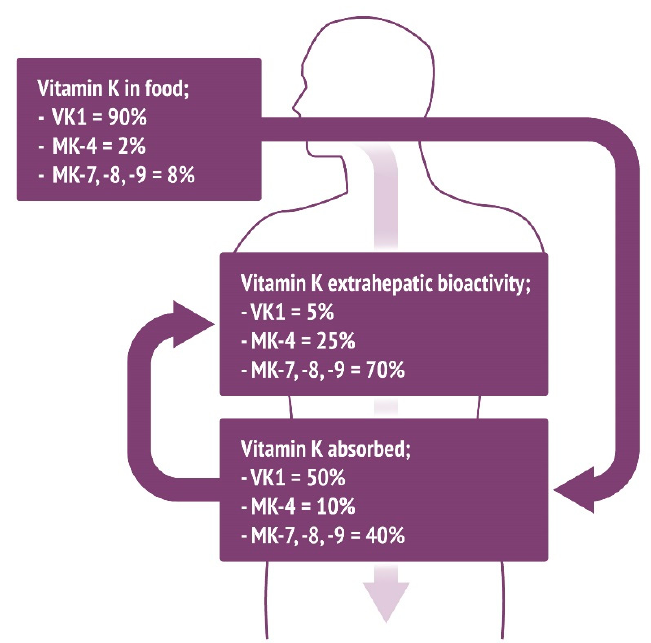
Figure 2. Intake of vitamin K and percentage of total absorbed vitamin K based upon estimated approximations of levels of vitamin K in the Western diet and previously determined absorption values. Given that VK1 is only 10–15% absorbed and that VK2 analogs are more completely absorbed, actual vitamin K levels vary significantly compared to the food content. Further to this, consumption of VK2 isoforms MK-7, -8, and -9 contributes to the majority of extrahepatic processes regulated by VKDPs.